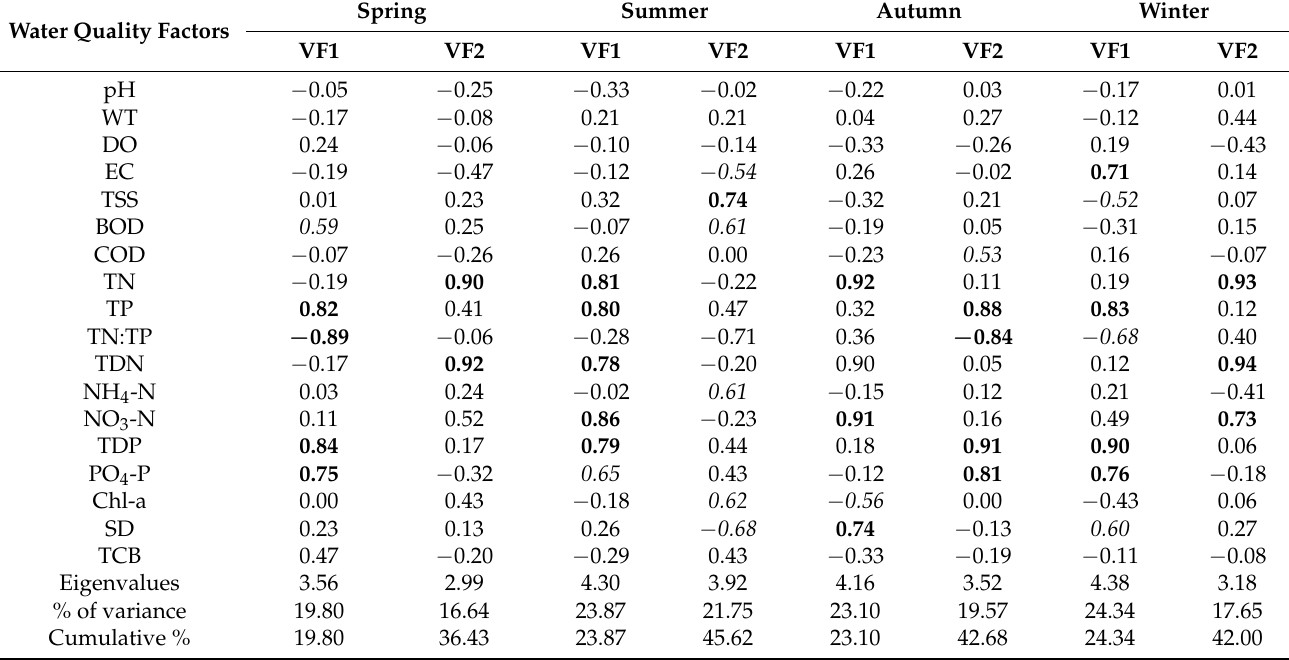
Table 4. Principal component analysis (PCA) of water quality parameters (units mgL − 1 , except pH, WT ( ◦ C), EC ( µ Scm − 1